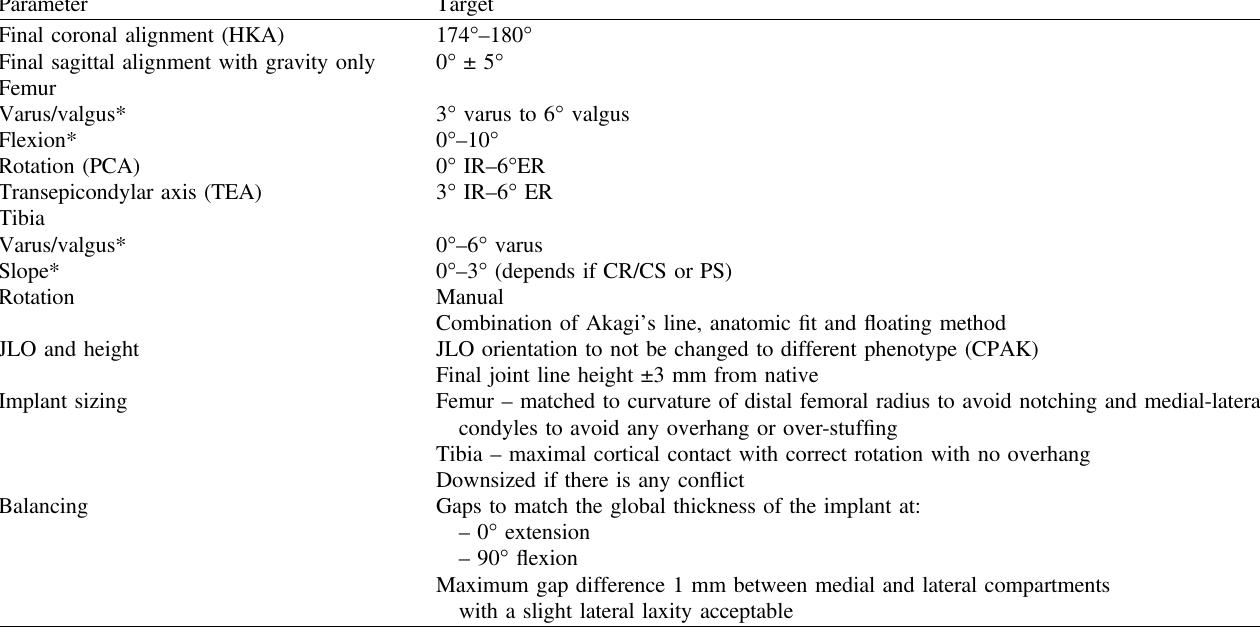
Table 1. Functional Alignment Philosophy Protocol Guidelines for the varus morphotype.